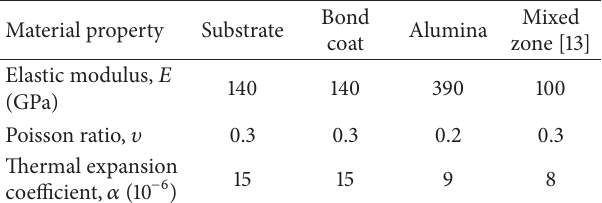
Table 1: Material property configuration for the finite element